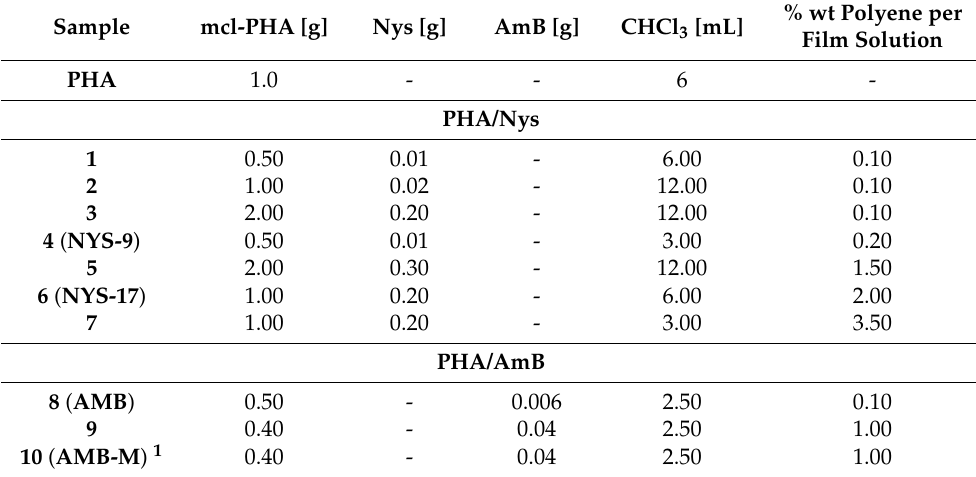
Table 2. Film samples, codes and compositions prepared via solvent casting approach.